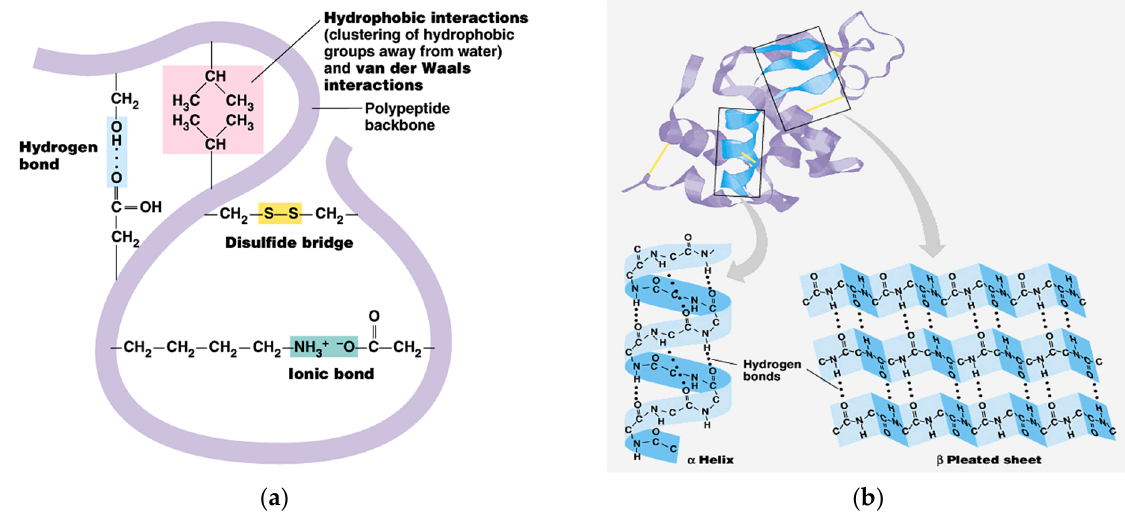
Figure 6. Keratin molecule with intra-molecular bonds ( a ) and transition of α -helix to β -sheets ( b ) [24].